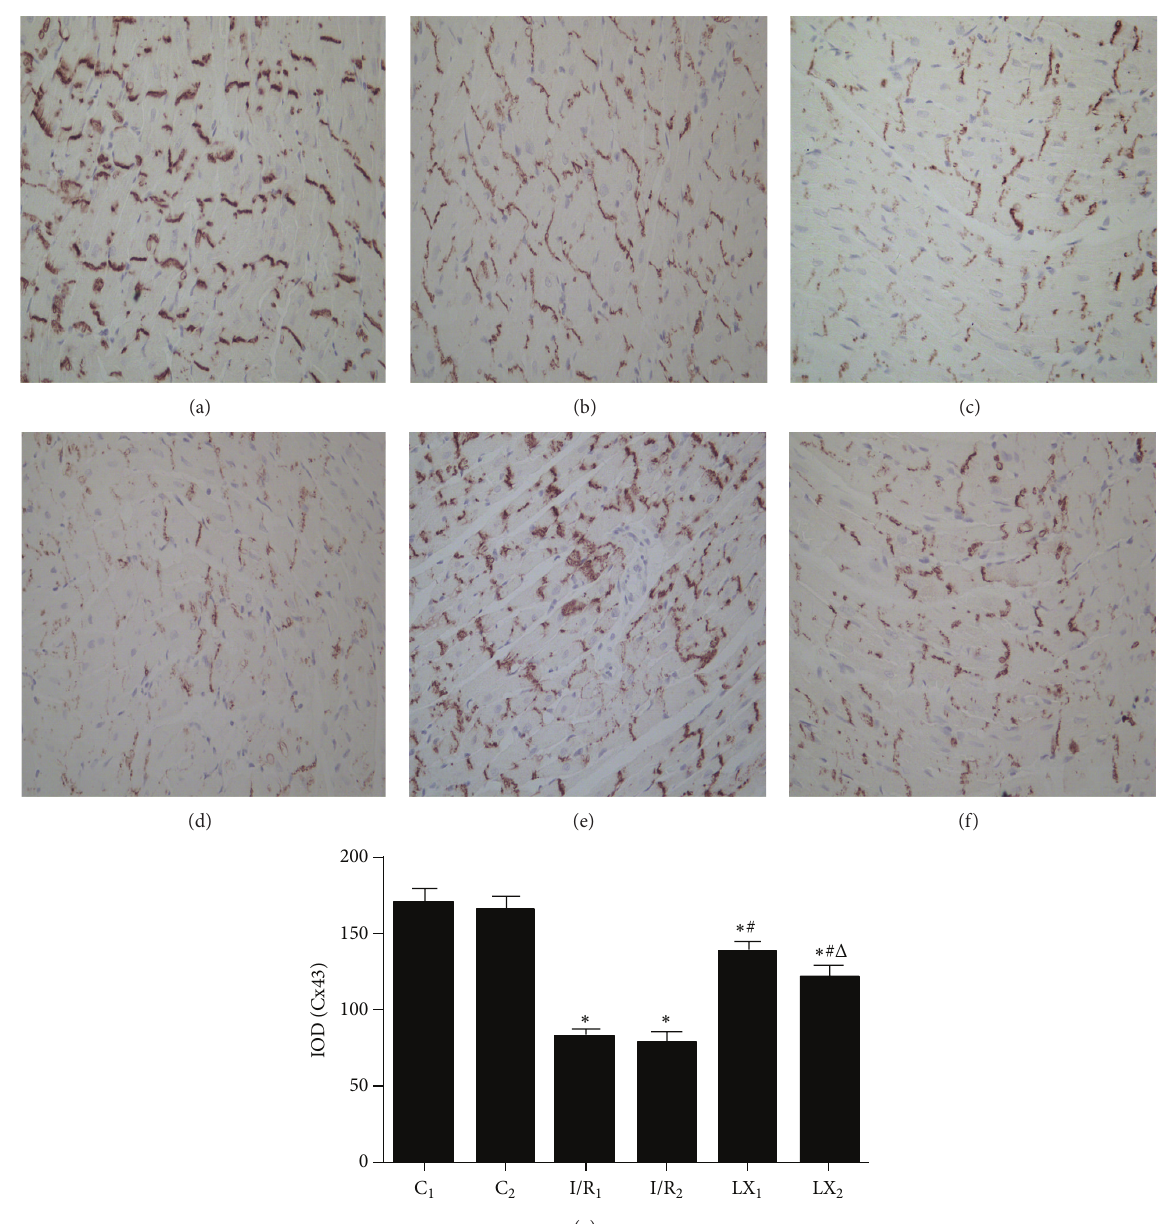
Figure 4: Immunohistochemical staining and IOD of Cx43 in cardiac tissues from rats of different groups at T 2 . (a) Group C 1 and (b) group C 2 : the Cx43 positive particle intensively and regularly was distributed and was clustered in the intercalated disk; (c) group I/R 1 and (d) group I/R 2 : sparsely distributed Cx43 positive particles; (e) group LX 1 and (f) group LX 2 : Slightly decreased Cx43 positive particles, mostly still clustered in the intercalated disk. (g) For IOD of Cx43. ∗ 𝑃 < 0.05 for comparisons of I/R 1 and LX 1 groups with C 1 group, 𝑃 < 0.05 for comparisons of I/R 2 and LX 2 with C 2 group; # 𝑃 < 0.05 for comparisons of LX 1 group with I/R 1 group, 𝑃 < 0.05 for comparisons of LX 2 group with I/R 2 group; Δ 𝑃 < 0.05 for comparisons of LX 2 group with LX 1